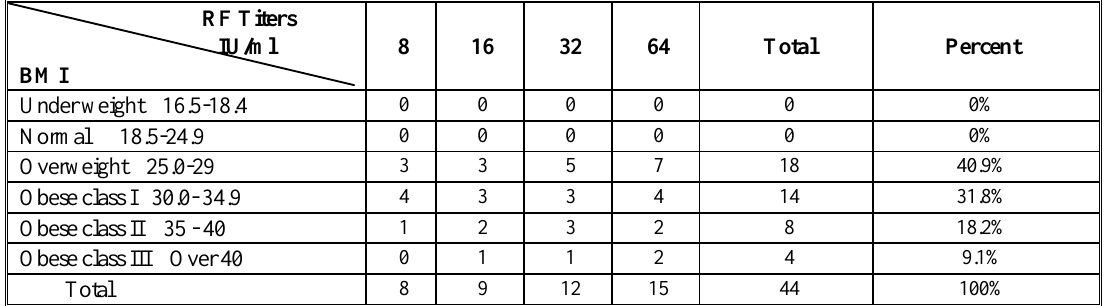
Table 5: Distribution of diabetic patients with RF positive according to their titer, in relationship to body mass index groups BMI (kg/m 2